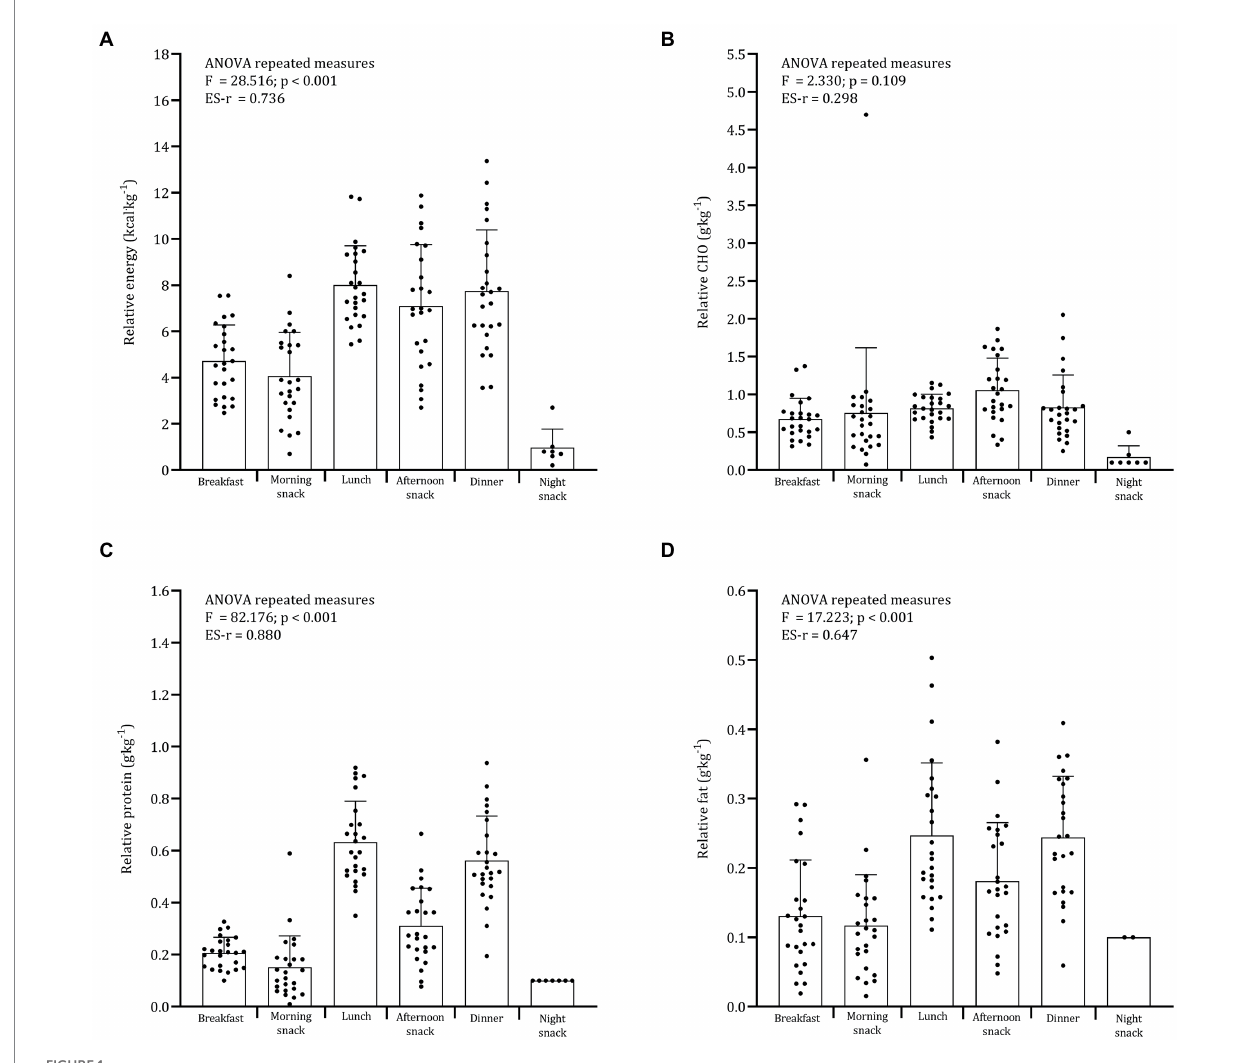
FIGURE 1 Daily distribution of relative (A) energy, (B) CHO, (C) protein, and (D) fat.